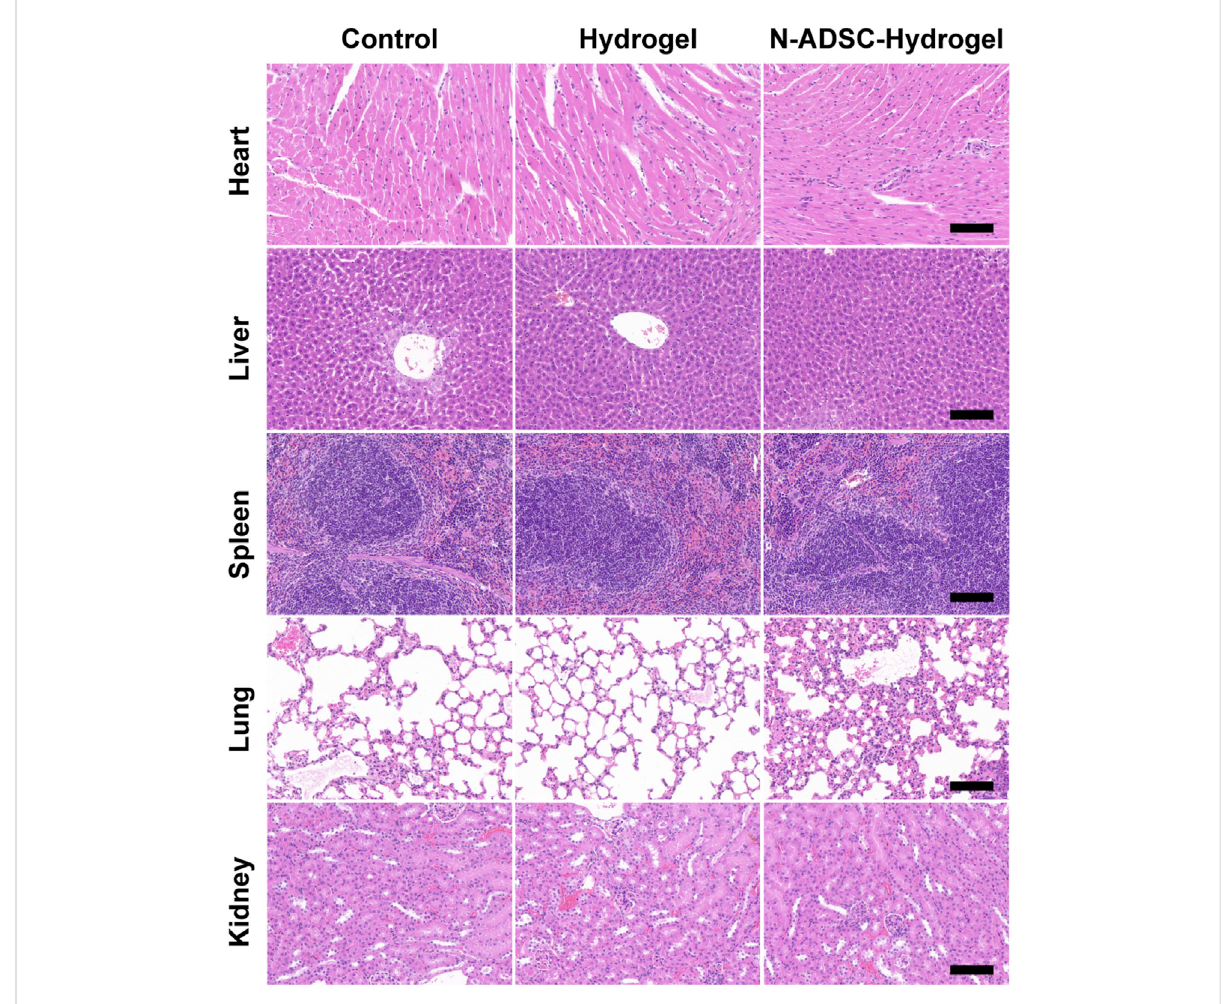
FIGURE 7 Biocompatibility of the N-ADSC-loaded adhesive DN hydrogel in vivo . HE staining of the heart, liver, spleen, lung and kidney from rats of the three experimental groups as detailed in Materials and